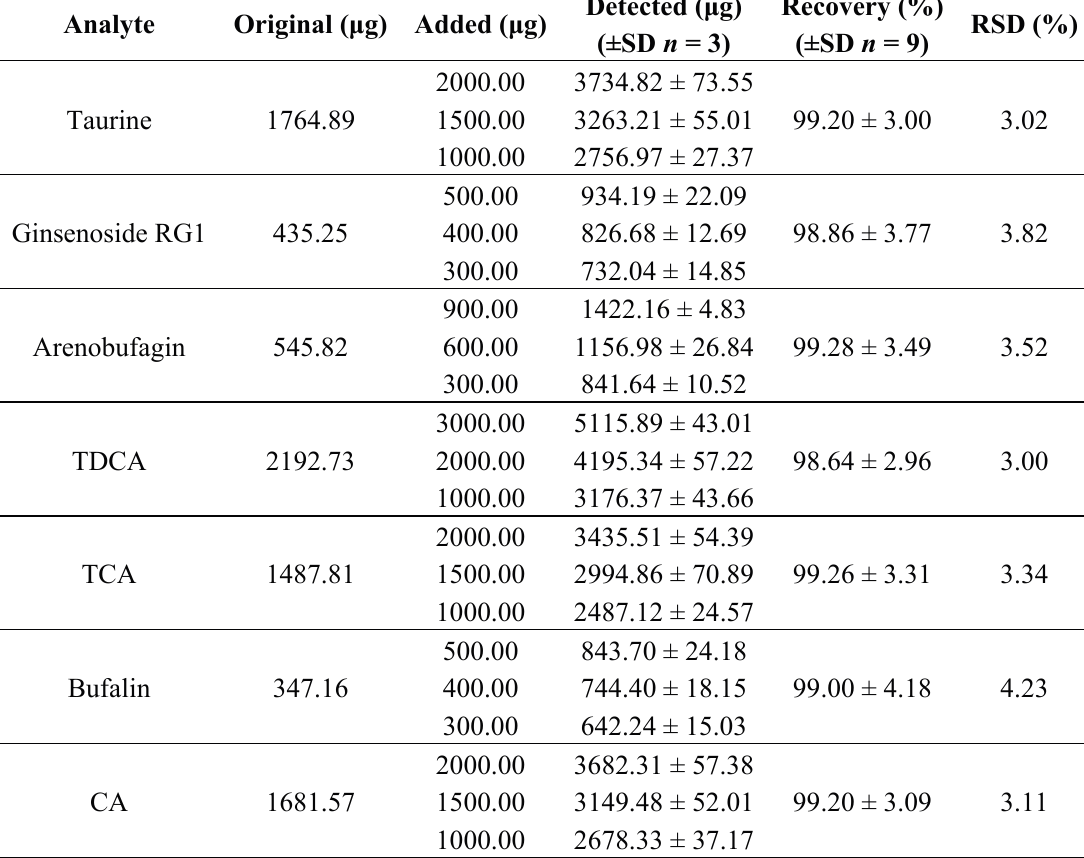
Table 4. Recoveries of 13 detected components of STP.